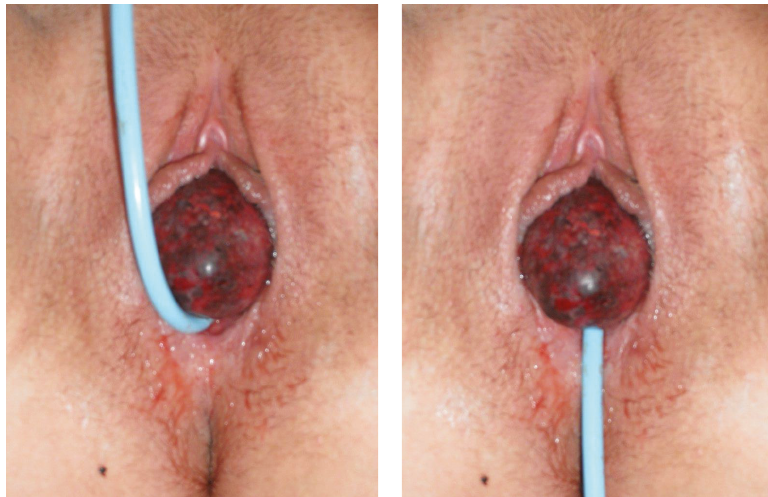
Figure 1: Initial clinical findings, after a transurethral catheter was placed. As will be seen in both pictures, we initially found a prolapsing vaginal mass, whose origin was not to be clearly identified without further examinations.